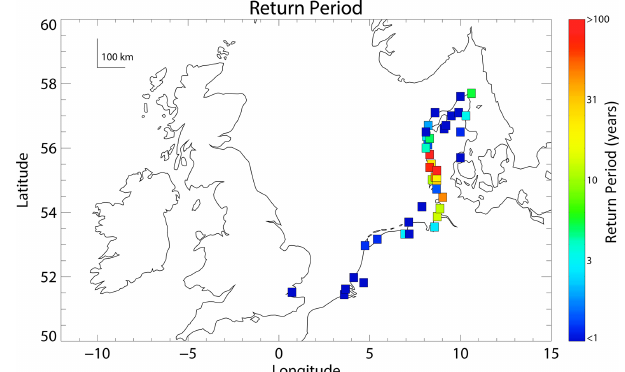
Figure 7. Return period of maximum water level during Storm Ana- tol 3–4 December 1999, as calculated from literature summary re-